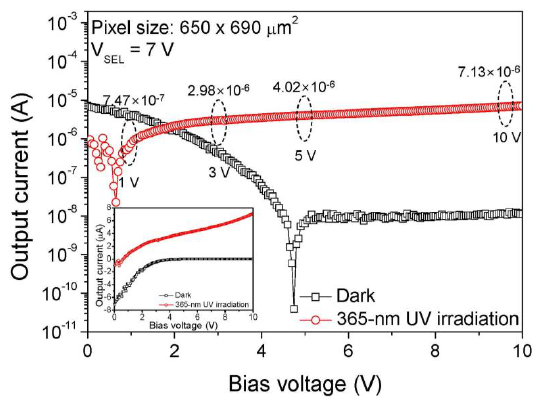
Figure 6. Output I – V characteristics of the fabricated GaN UV PPS with/without UV irradiation under 0 – 10 V bias conditions. (Inset: linear scale output I – V characteristics).